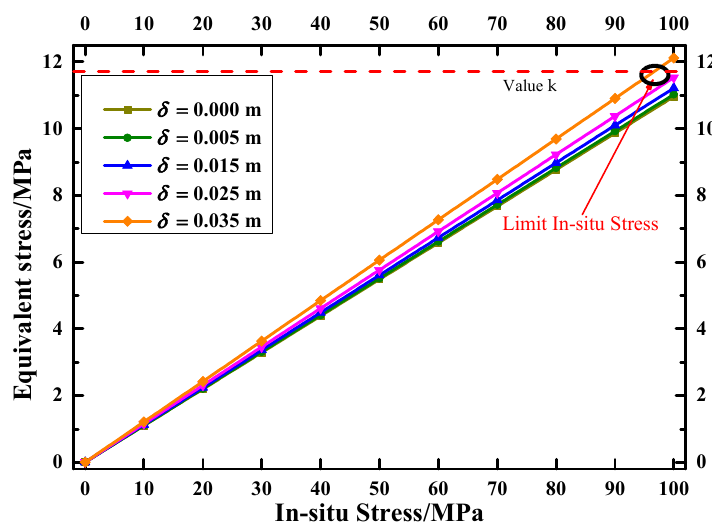
Figure 9. Variation of equivalent stress with the increase of crustal stress in different eccentricity δ .